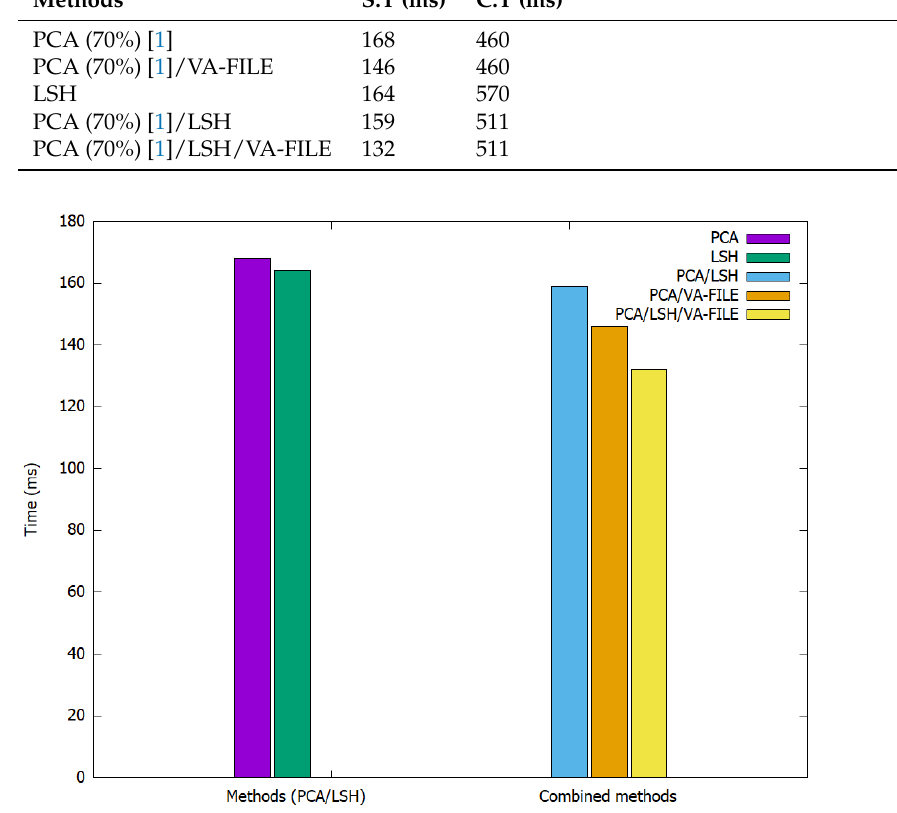
Figure 4. Computation and the research time within Wang database.